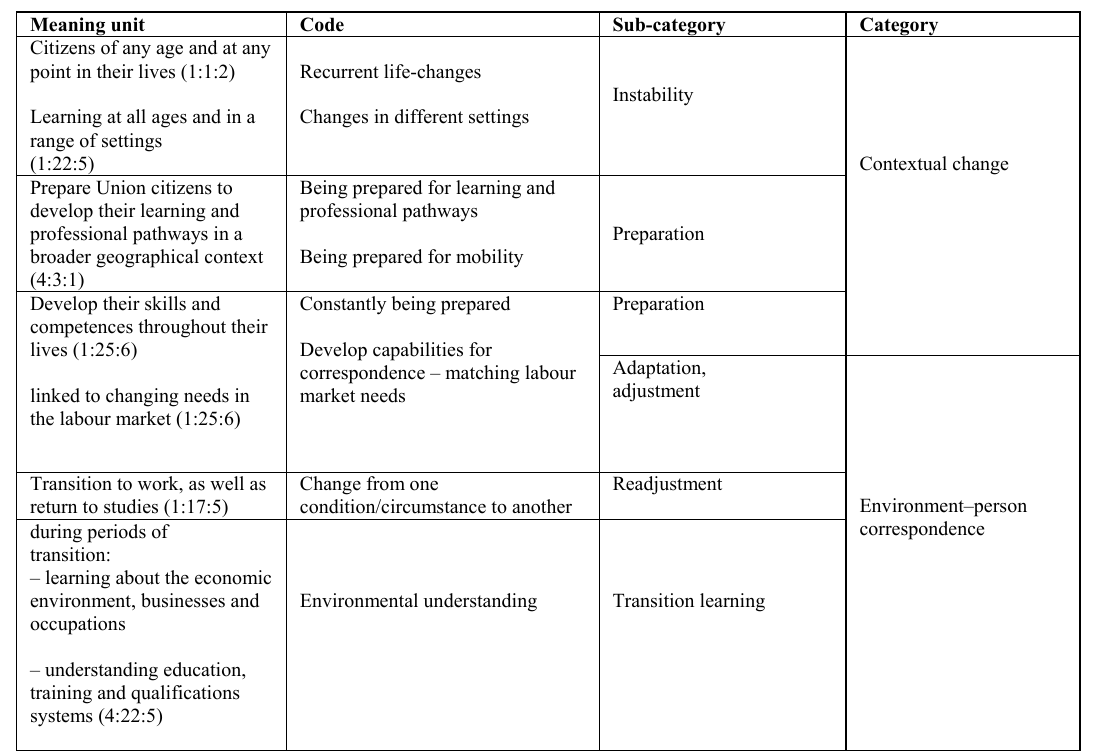
Table 1. Example of the analysis process, going from meaning units towards code, sub- category and